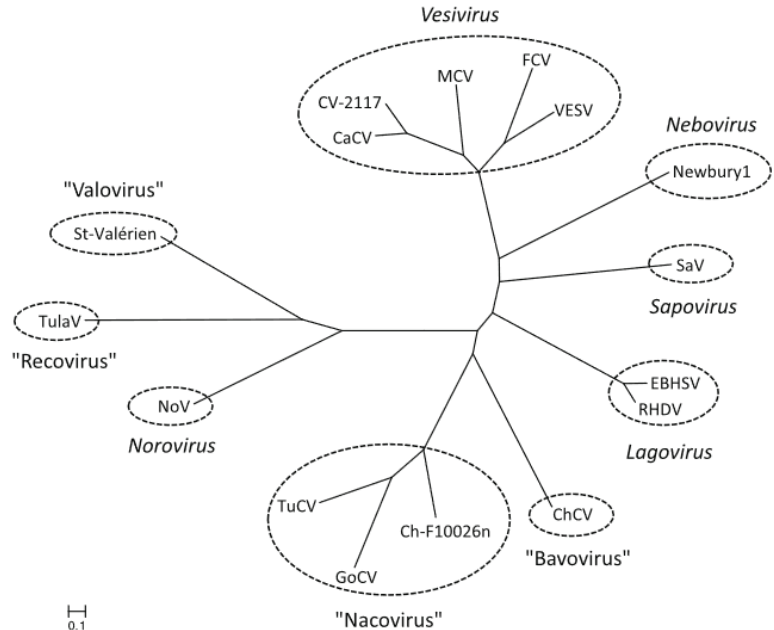
Figure 4. Phylogenetic relationship between the Nacovirus genus and other genera of the Caliciviridae , based on full length amino acid sequences of VP1, the major capsid protein. The calibration bar indicates genetic distance. Abbreviations: CaCv, canine calicivirus; ChCV, chicken calicivirus Bavaria; Ch-F10026n, chicken calicivirus F10026n; CV-2117, calicivirus 2117; EBHSV, European brown hare syndrome virus; FCV, feline calicivirus; GoCV, goose calicivirus; MCV, mink calicivirus; Newbury1, Newbury-1 virus; NoV, norovirus; RHDV, rabbit haemorrhagic disease virus; SaV, sapovirus; St Valérien, St Valérien virus; TuCV, turkey calicivirus; TulaV, Tulane virus; VESV, vesicular exanthema of swine virus. From reference [29], with permission of authors and publisher.